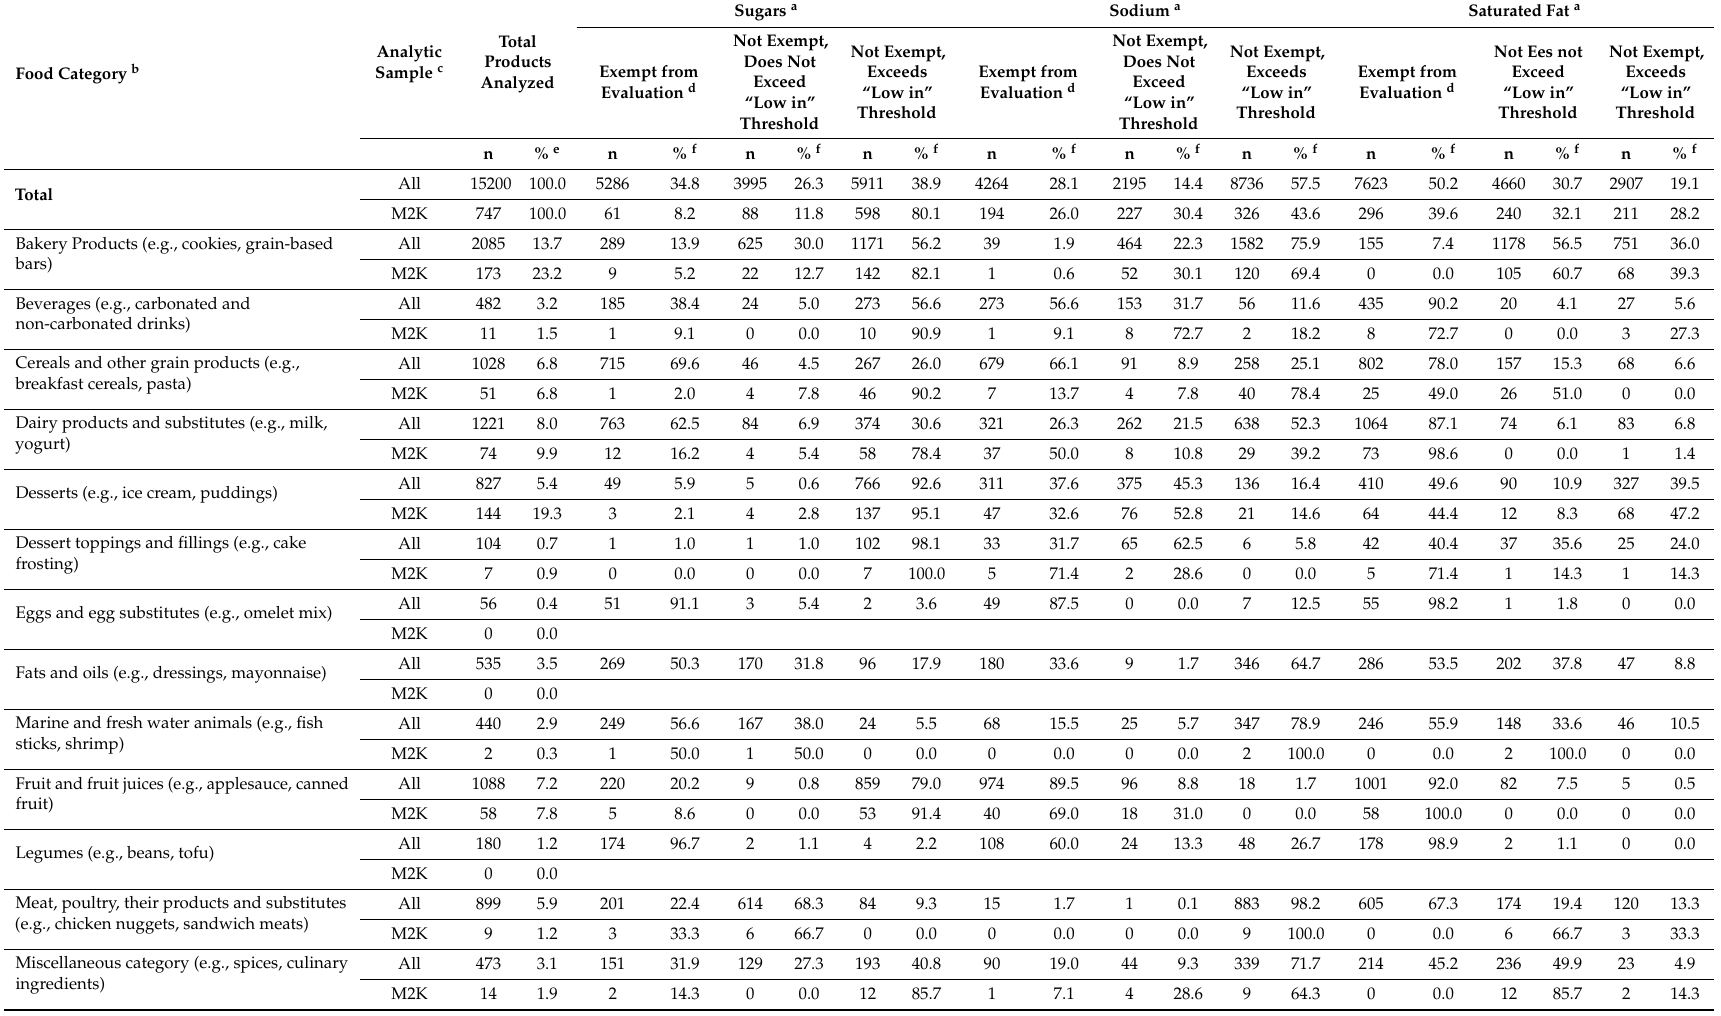
Table 4. Number (n) and proportion (%) of products exceeding each nutrient